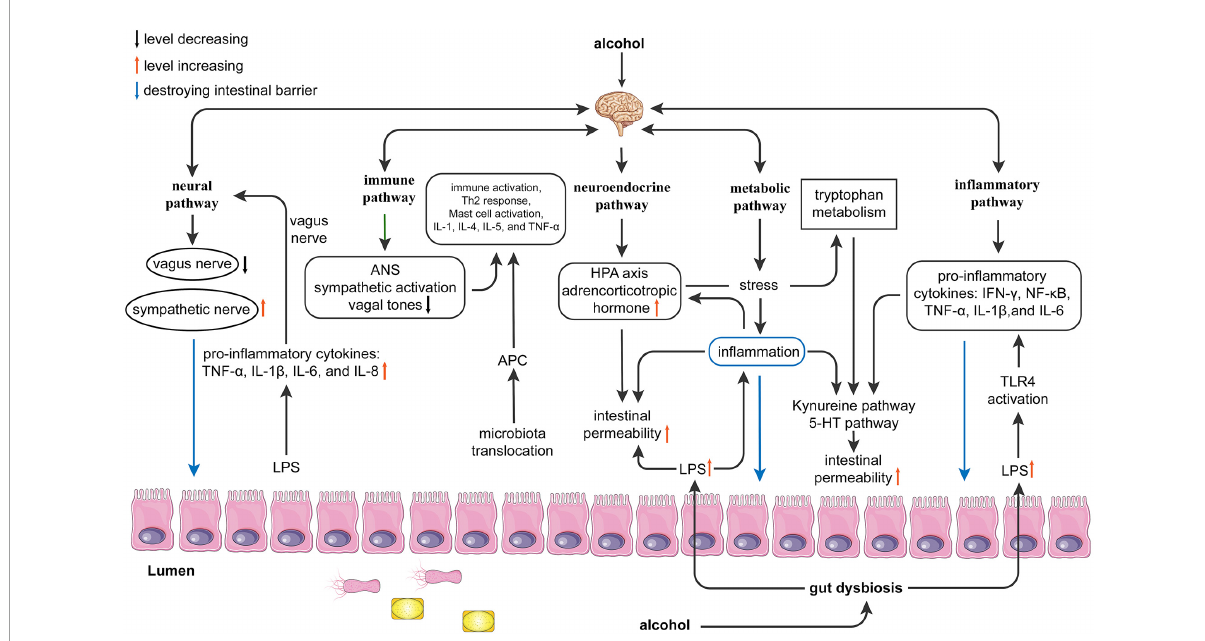
FIGURE1 Possible mechanisms of alcohol effects function on the gut-brain axis. Alcohol can cause gut dysbiosis and affect brain function through the neural, immune, neuroendocrine, metabolic, and inflammatory pathways. Neural pathway: Alcohol leads to gut dysbiosis and increased lipopolysaccharides (LPS), which leads to increased release of proinflammatory cytokines [Tumor necrosis factor (TNF)- α , interleukin (IL)-1 β , IL-6, and IL-8] and activation of the vagus nerve affecting the brain. The brain affects the gut by inhibiting the vagus nerve and exciting sympathetic nerves; Immune pathway: Alcohol promotes microbiota translocation, which leads to antigen-presenting cells activating the Th2 response and mast cells and releasing proinflammatory cytokines (IL-1, IL-4, IL-5, and TNF- α ). The brain can affect the gut by activating the sympathetic nerve and decreasing vagal tone, which causes immune activation. Neuroendocrine pathway: LPS causes inflammation and activates the hypothalamic-pituitary-adrenal axis (HPA) axis to affect the brain. The brain can affect the gut by affecting the HPA axis to release adrenocorticotropic hormones, resulting in increased intestinal permeability. Metabolic pathway: Alcohol interferes with the metabolism of tryptophan by causing inflammation and affects the kynurenine and 5-HT pathways, which affect brain function. In addition, the reduction of small chain fatty acids (SCFAs) can affect the brain and gut in both directions. Inflammatory pathways: Alcohol directly affects the brain and gut in both directions by mediating LPS-induced inflammation and releasing inflammatory factors [interferon (IFN)- γ , nuclear factor (NF)- κ B, TNF- α